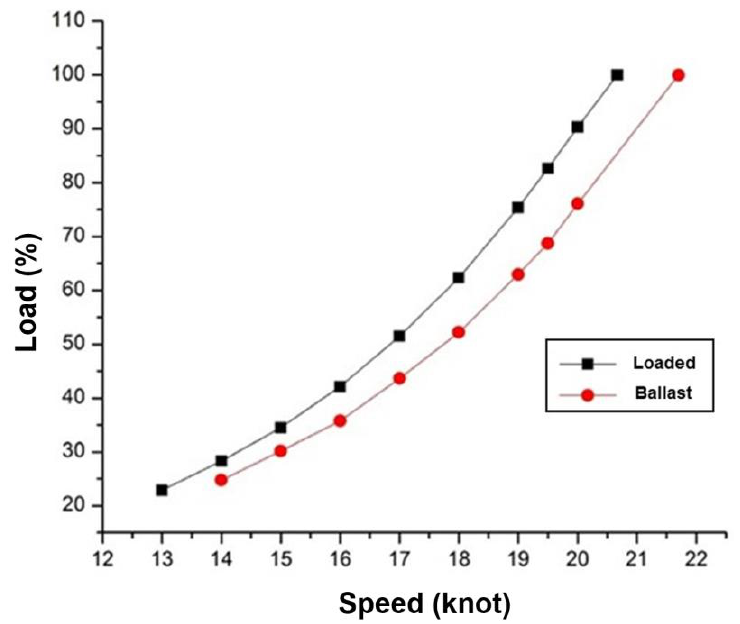
Figure 9. Graph of loading of the system and ship speed.